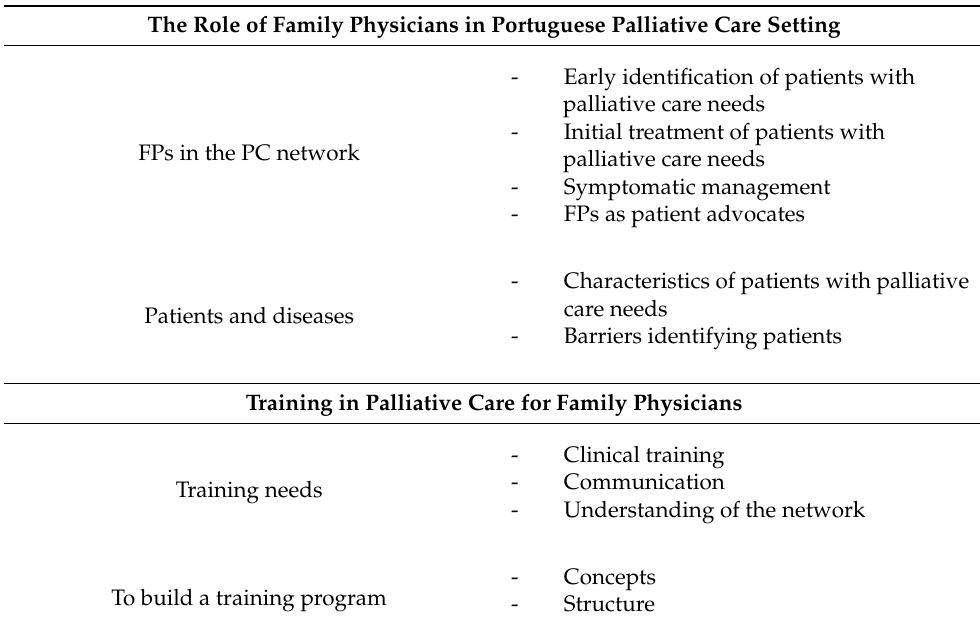
Table 2. Main themes and subthemes obtained through focus online groups. The Role of Family Physicians in Portuguese Palliative Care Setting